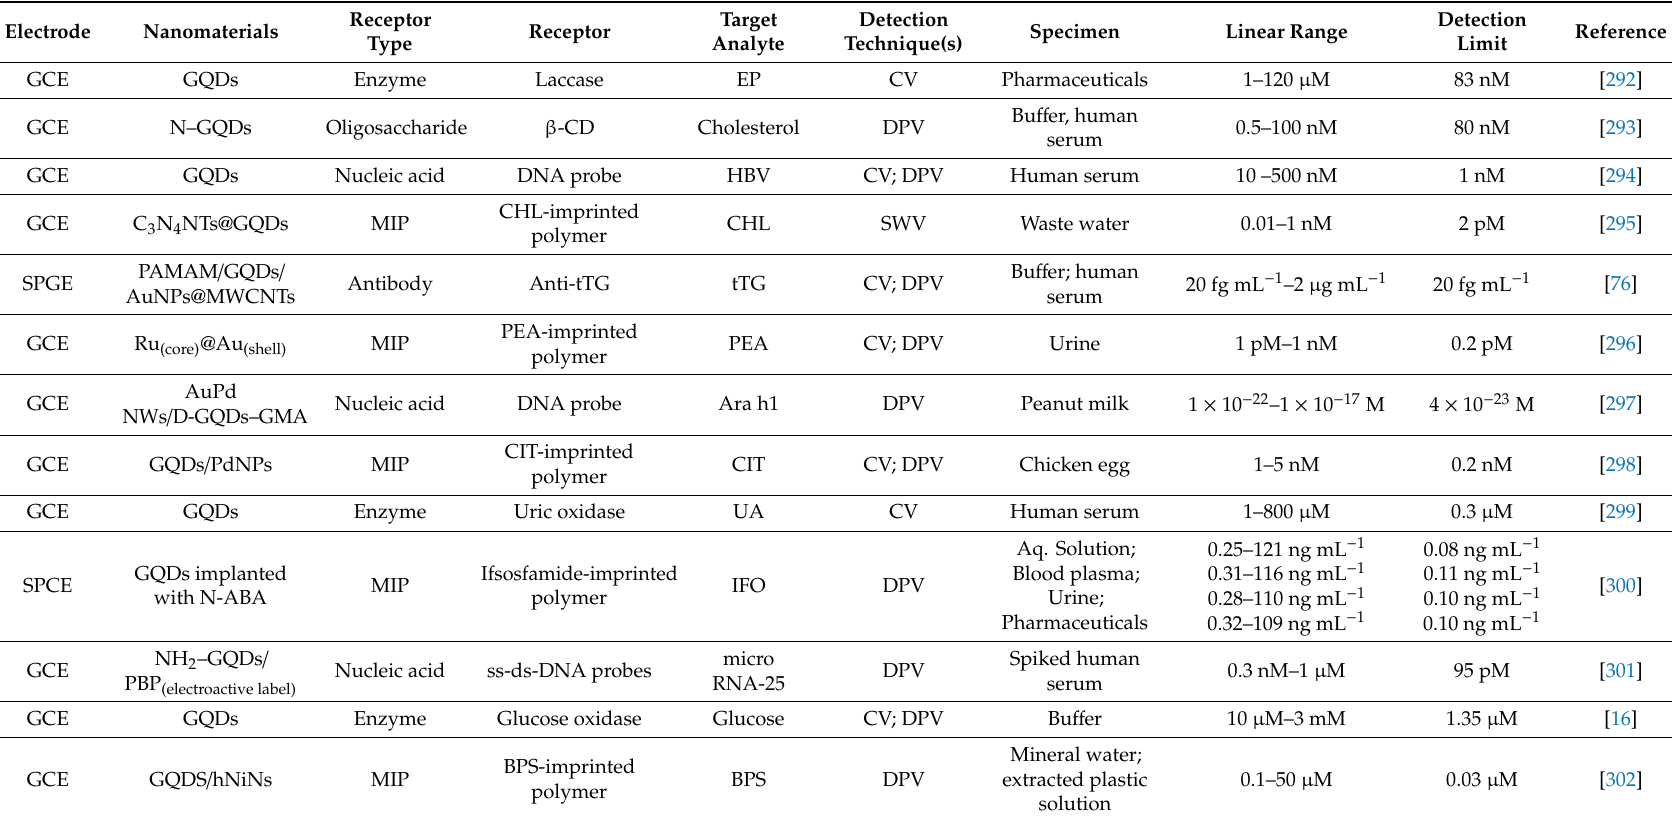
Table 4. Various GQD-based voltammetric sensors reported (2017 onwards) for biomedical